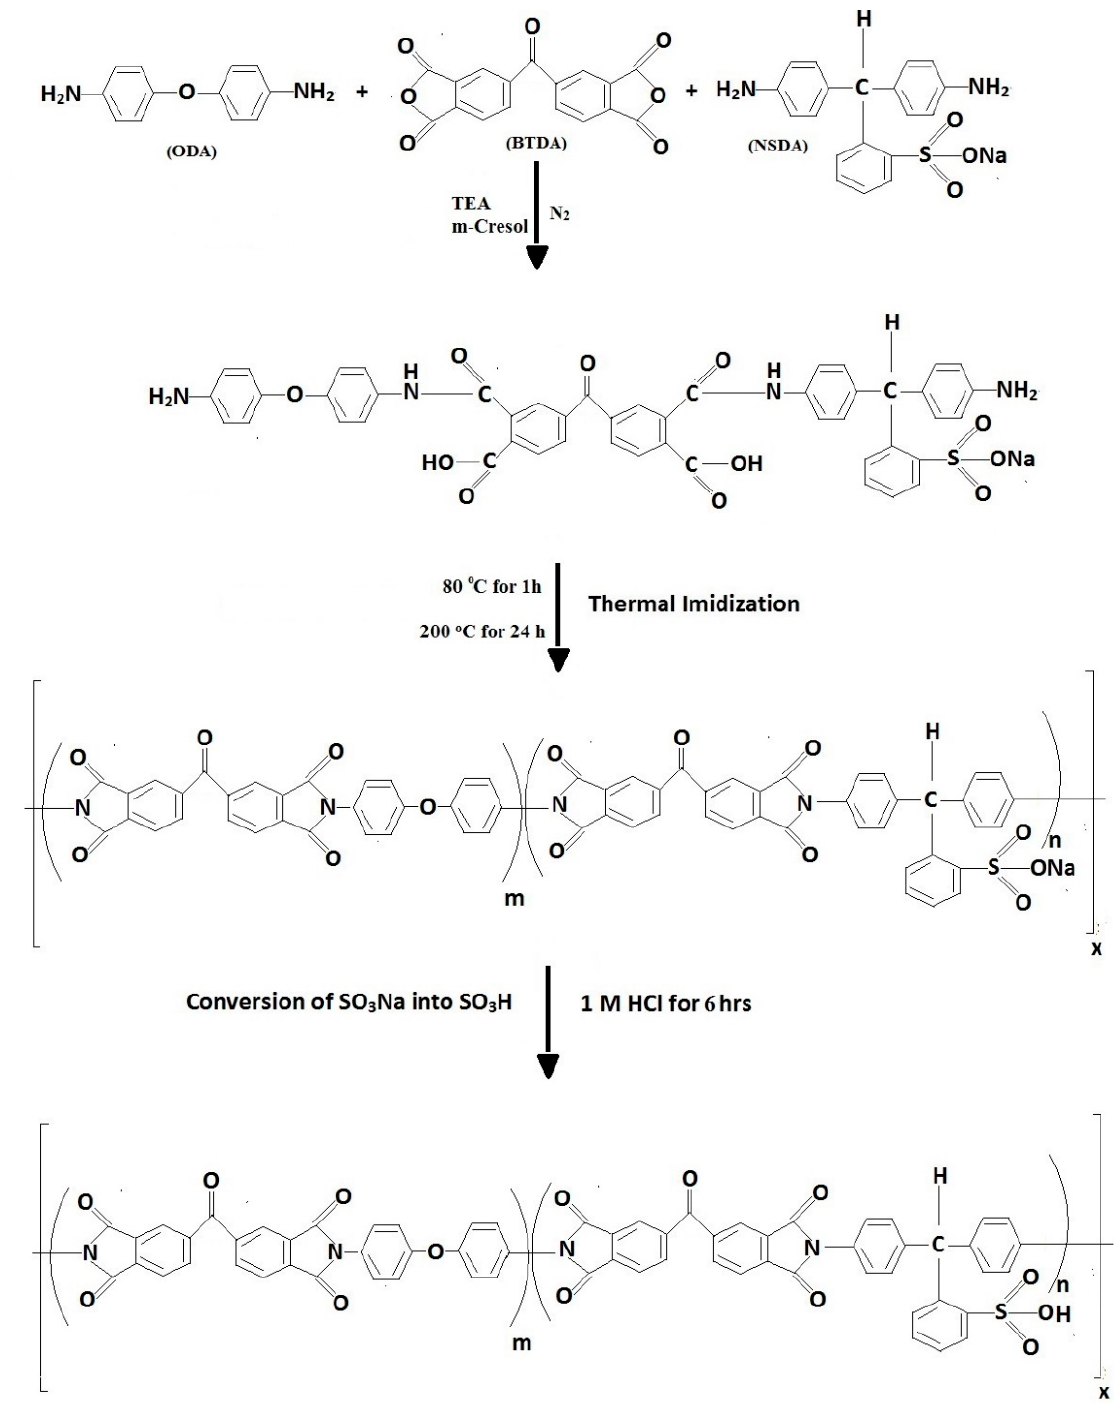
Figure 2. Synthesis of a novel sulfonated polyimide (NSPI).